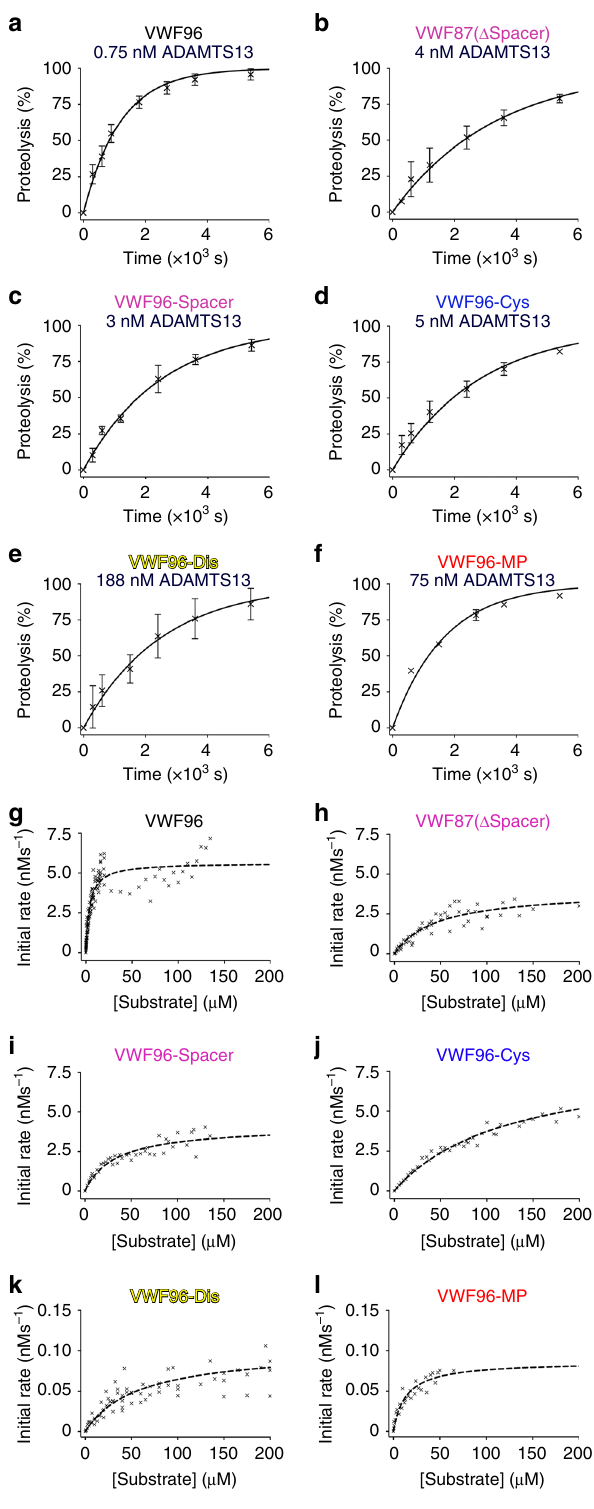
exosite interaction in fl uences VWF proteolysis, we derived the